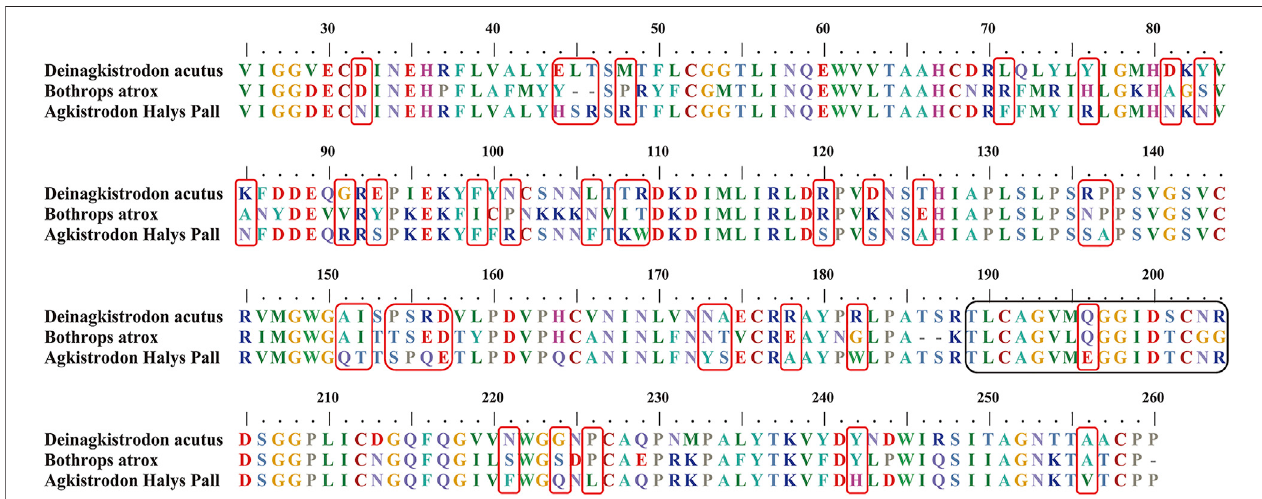
FIGURE 2 | Partial sequence alignments of snake venom thrombin-like enzymes in Deinagkistrodon acutus , Bothrops atrox , and Agkistrodon halys pallas . The uniqueaminoacidresiduesfor Agkistrodon halyspallas areindicatedinredboxes.Thetheoreticaltrypticmarkerpeptidewhichcontainstheuniqueaminoacidresidues studied in this work is in black